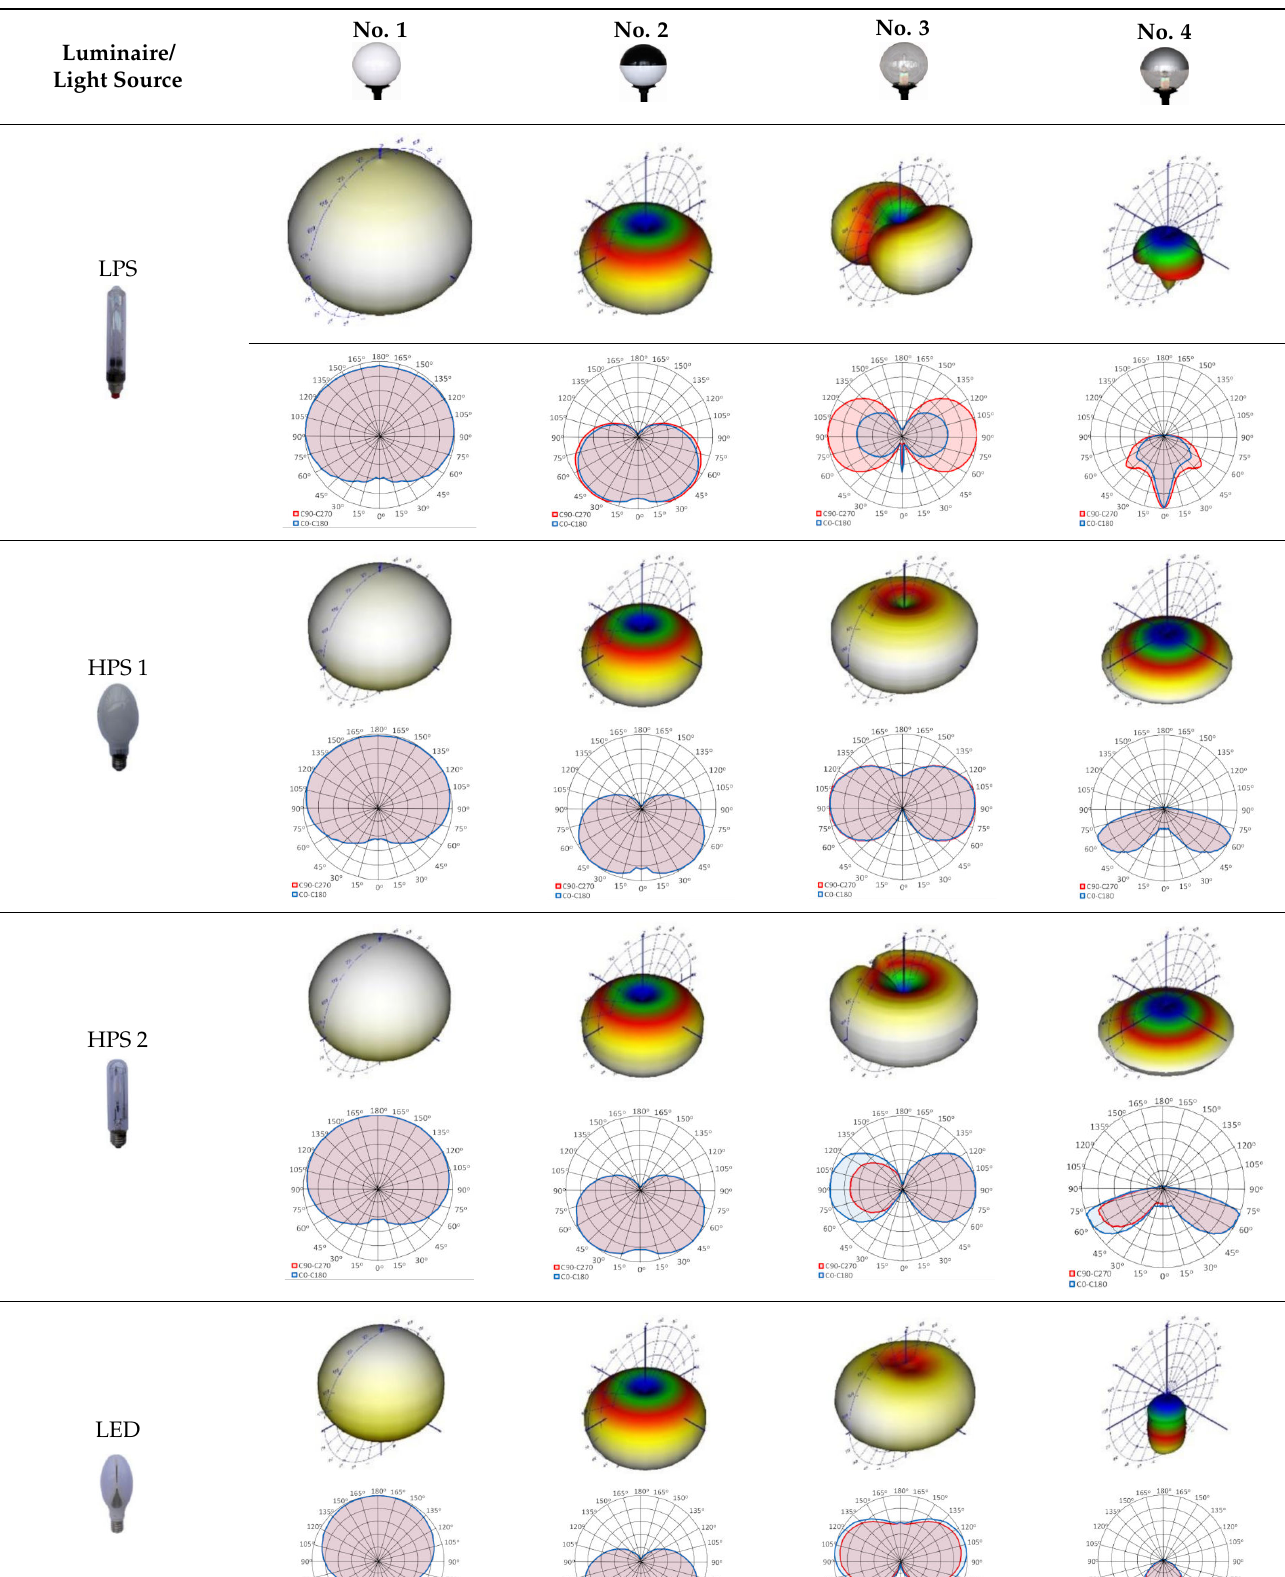
Table 3. Graphical representation of the method of light distribution by the luminaires from 1 to 4. Luminaire/